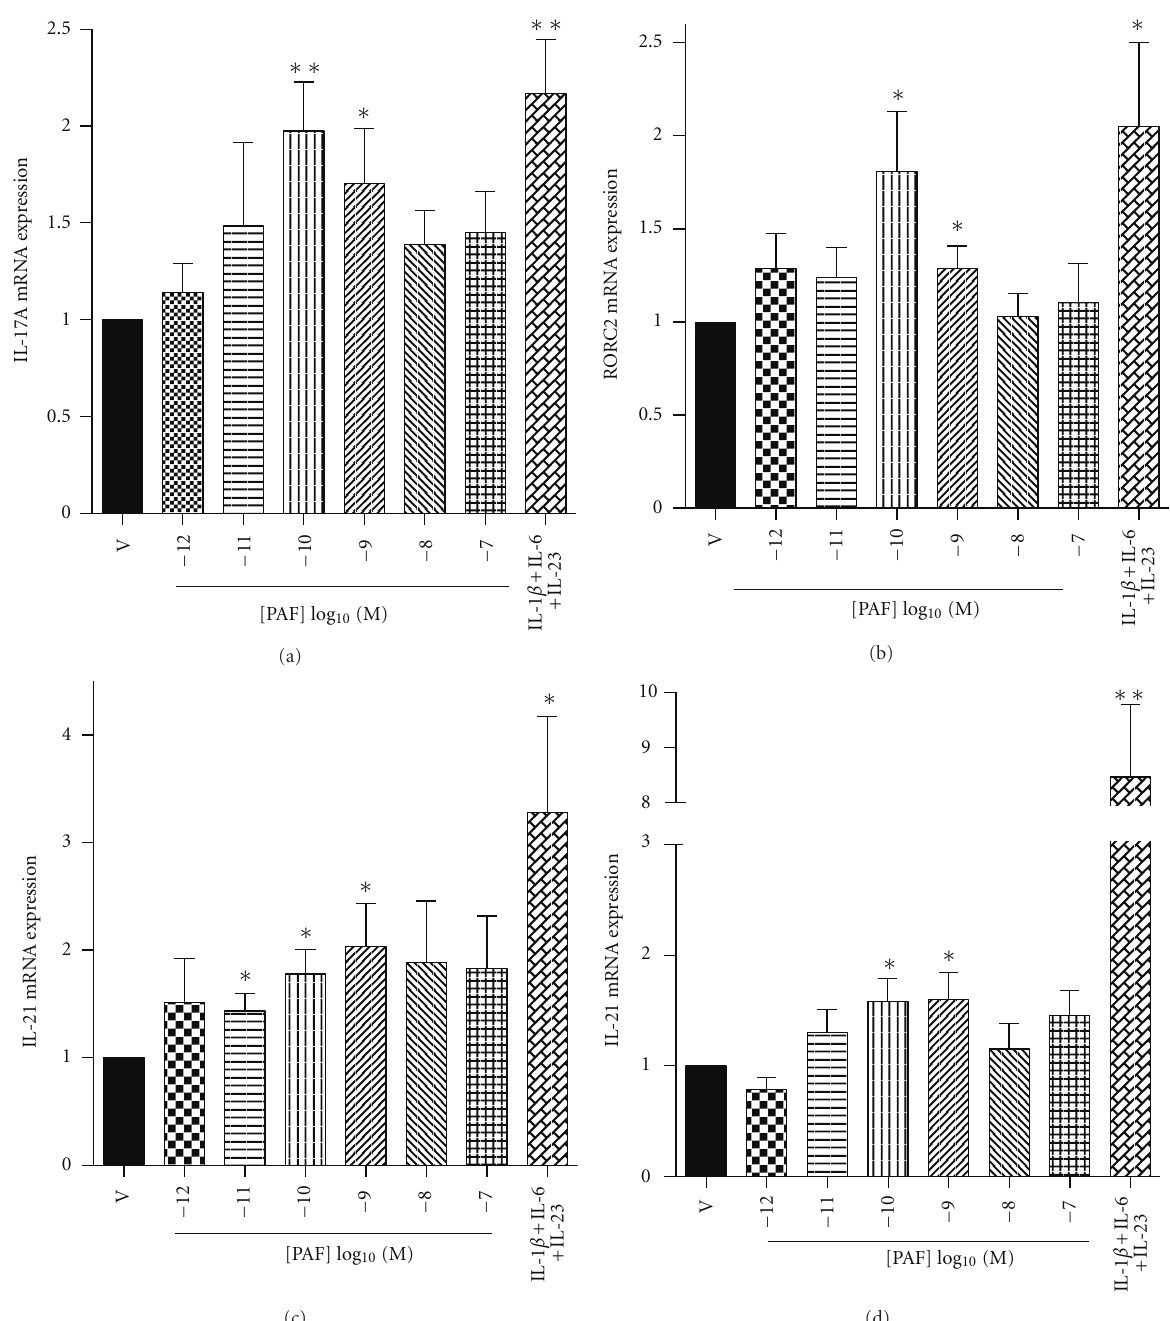
Figure 4: PAF-stimulated LC induce Th17 mRNA markers in cocultured T cells. Monocyte-derived LC were stimulated with graded concentrations of PAF or its vehicle (ethanol; V) and cocultured with antiCD3/CD28-activated CD4 + T cells for 5 days. IL-17A (a), RORC2 (b), IL-21 (c), and IL-22 (d) mRNA expression was measured by real-time quantitative PCR in CD4 + T cells. For comparison, CD4 + T cells were cultured alone with IL-1 β , IL-6, and IL-23 for 5 days. Data (means ± SEM) are expressed as fold induction relative to vehicle (V) control. n = 8; ∗ P < 0 . 05; ∗∗ P < 0 .